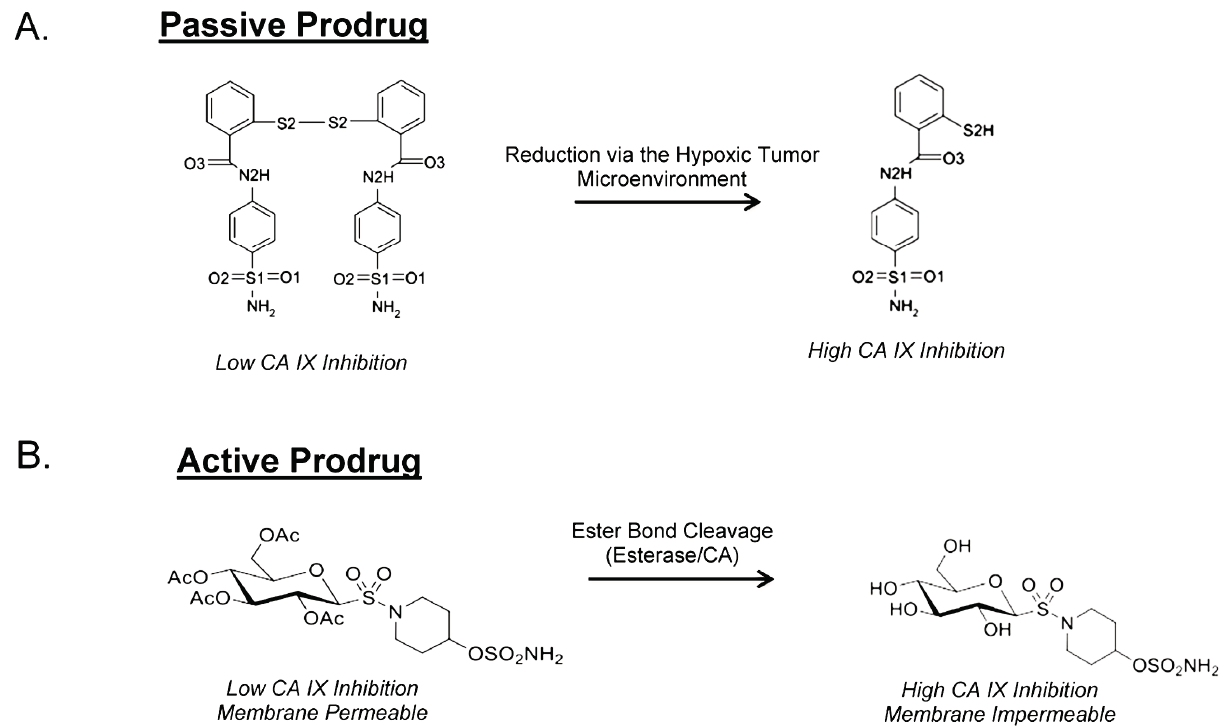
Figure 6. Prodrug CAIs. ( A ) Passive prodrug CAIs (4-(2-mercaptophenylcarboxamido) benzenesulfonamide) utilizes the microenvironmental changes to become